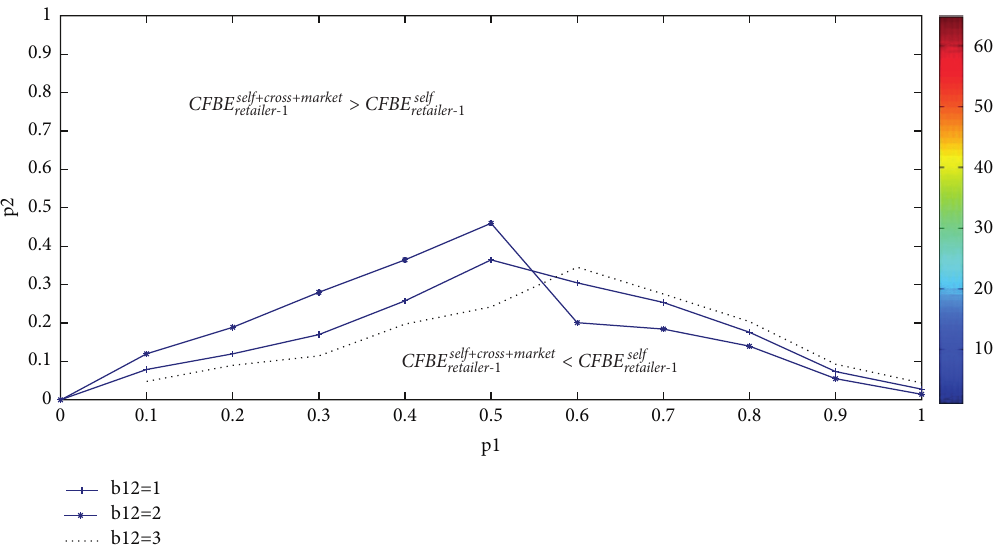
Figure 4: The impact of b